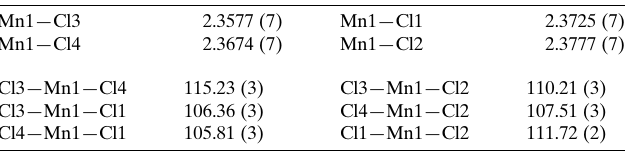
Table 1 Selected geometric parameters (A˚ , (cid:2) ).